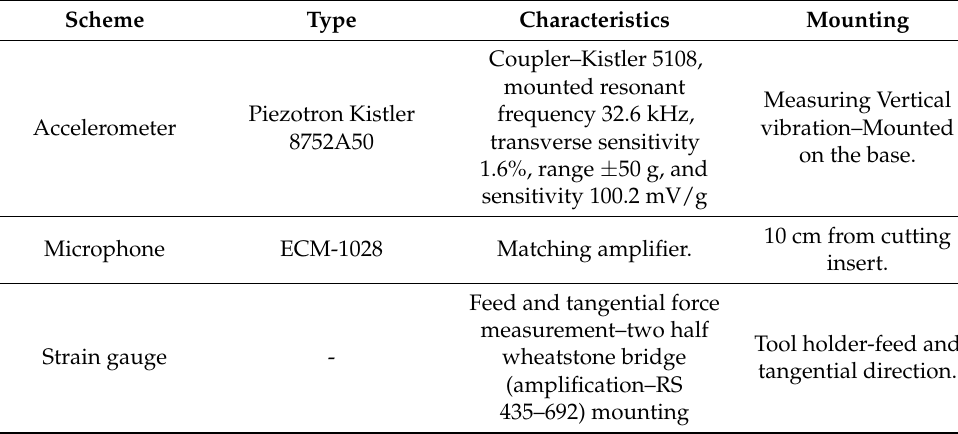
Figure 2. Flank wear evolution with time: 350 m/min, 0.25 mm/rev, and 1 mm depth of cut. The complexity of the cutting dynamics, as well as the noise present in sampled in- formation, makes it difficult to deploy a robust condition monitoring system set to work in real manufacturing conditions. Hence, a deeper understanding on the nature, robust- ness, and effectiveness of each of the wear-related acquired information is needed. As can be seen from Figure 2, as the tool life comes to its end, there are slight differences in tool life between cutting tips, which proves difficult to anticipate or otherwise model given the wide range of variables governing the cutting process dynamics. 4. Results and Discussion